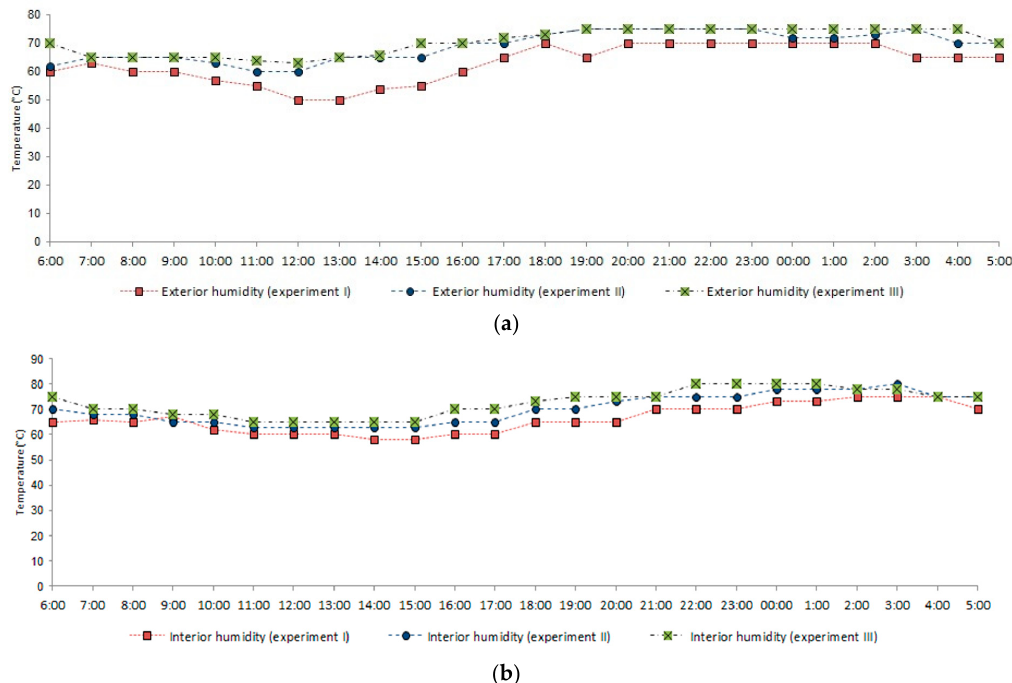
Figure 8. Comparison between: ( a ) exterior space humidity and ( b ) interior space humidity of bare wall and green facade. wall and green